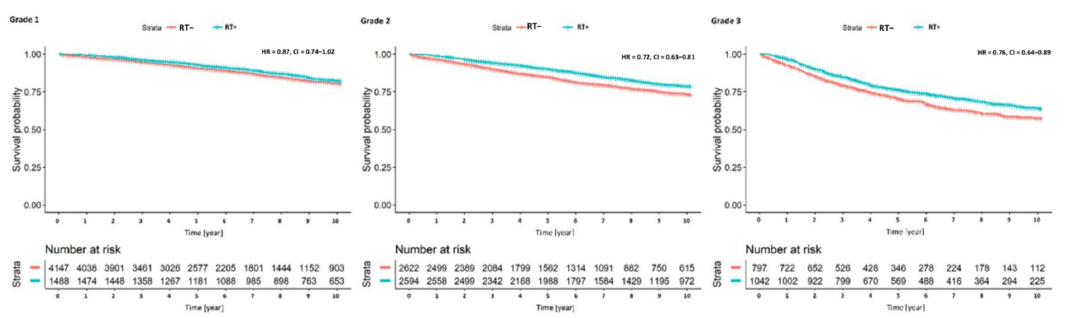
Figure 3. Stage-specific Kaplan-Meier survival plot (Stage IA and IB) of cases with and without radiotherapy, HR = hazard ratio with 95% confidence intervals.